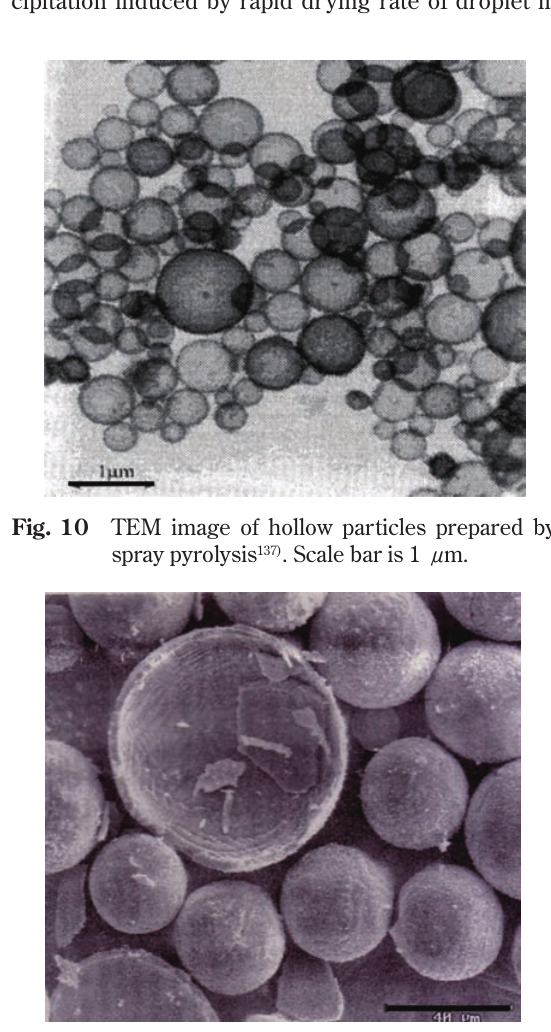
Fig. 11 SEM image of hollow Al 2 O 3 particles prepared by spray pyrolysis 138) . Scale bar is 40 μ m.